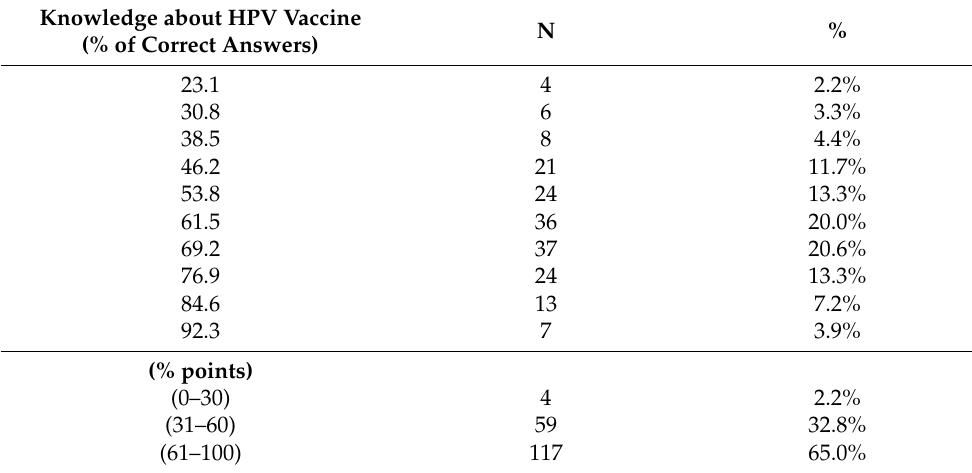
Table 4. Summary test results—knowledge about HPV vaccine.